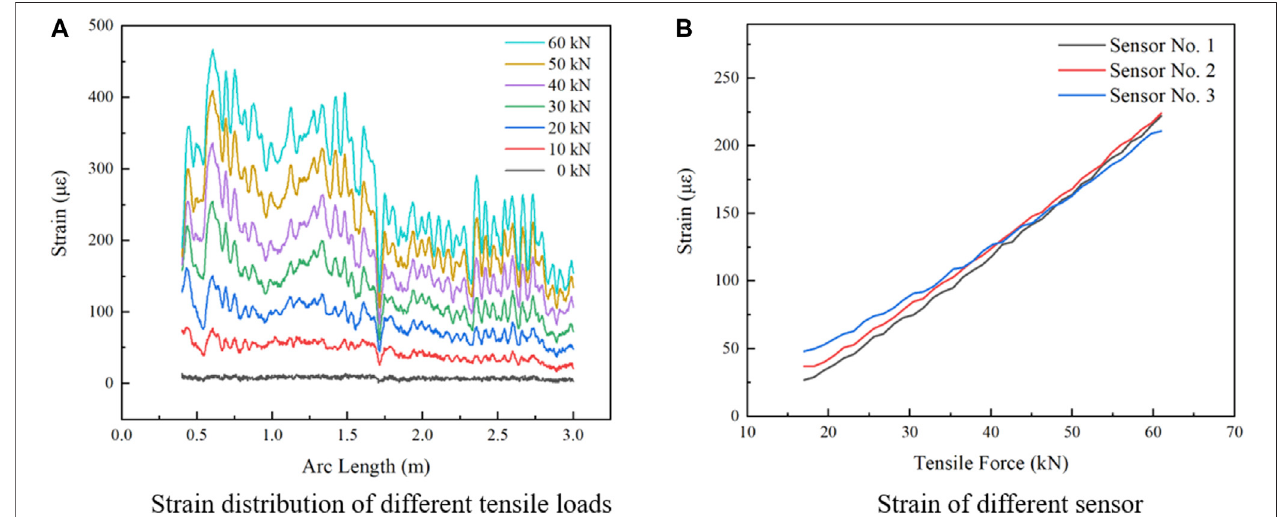
FIGURE 6 | Strain results of tension test.